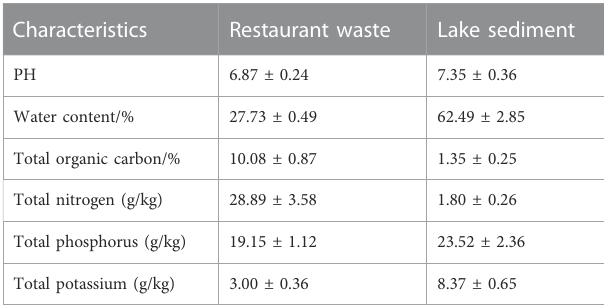
TABLE 1 Characteristics of restaurant waste and lake